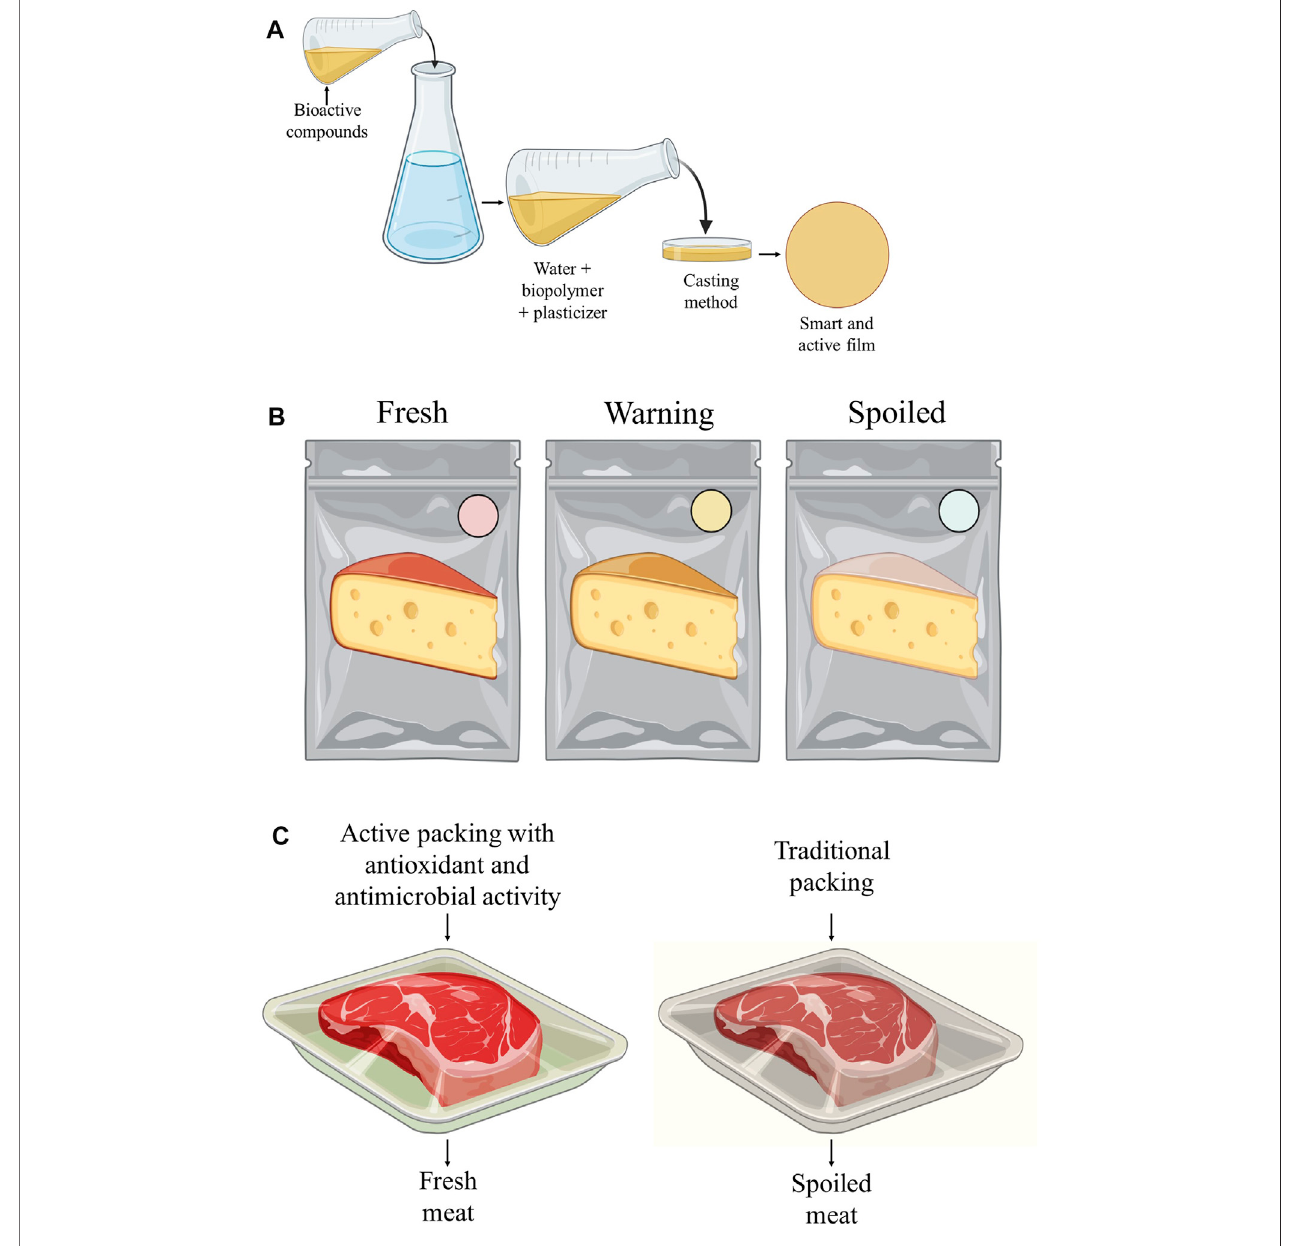
FIGURE 4 | (A) production of fi lms by casting. (B) application as smart packaging, and (C) application as active food packaging.